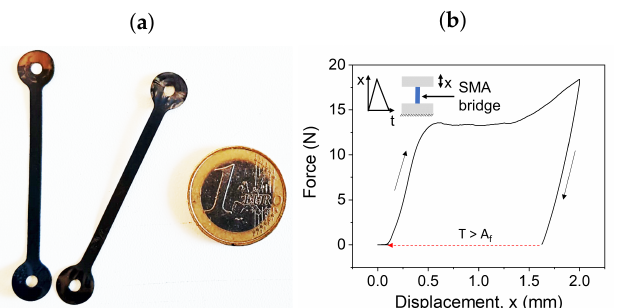
Figure 8. Picture of SMA bridge damper ( a ) and the damper’s mechanical behaviour under tensile loading ( b